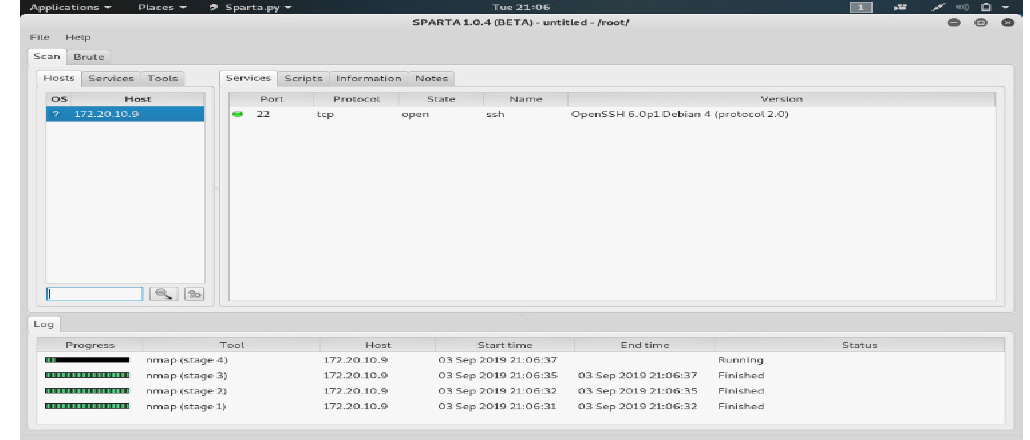
Fig. 13: Kali Linux operating system installed for attacks at IEMS